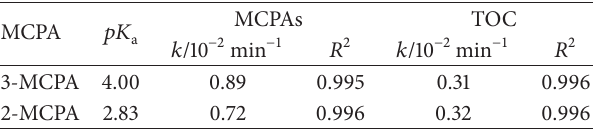
Table 4: Apparent rate constants, 𝑘 MCPA and 𝑘 TOC , for the decay of MCPAs and